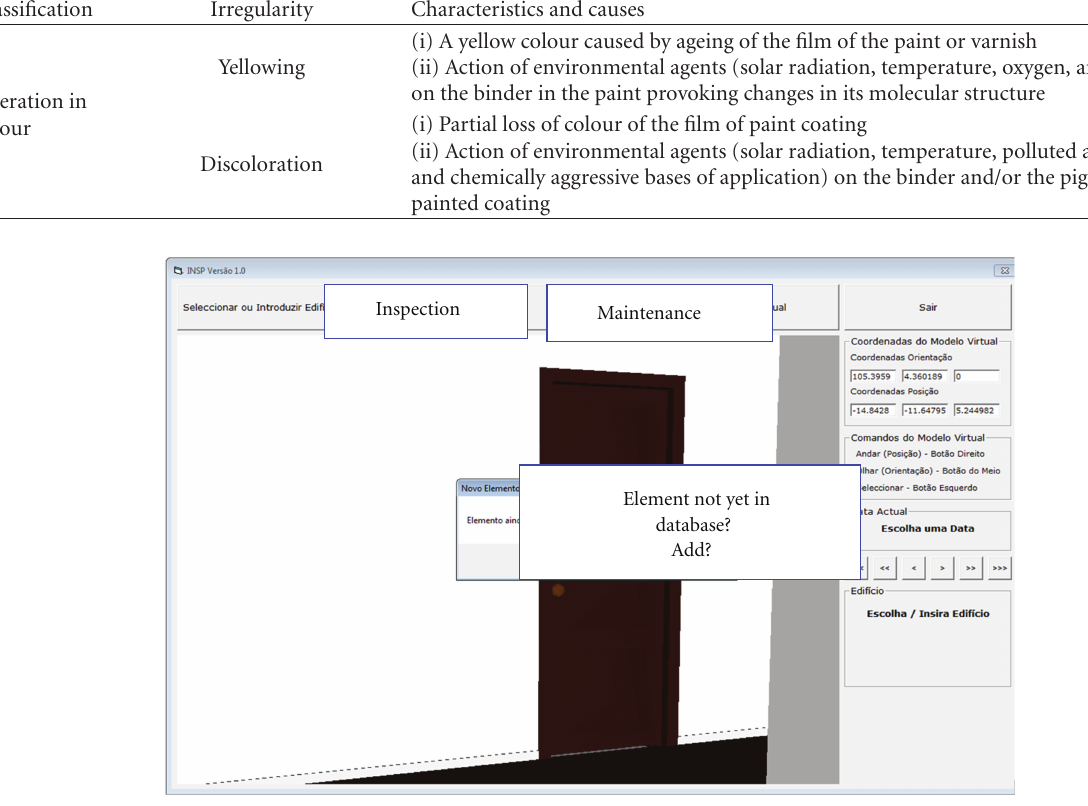
Figure 2: The main interface of the virtual